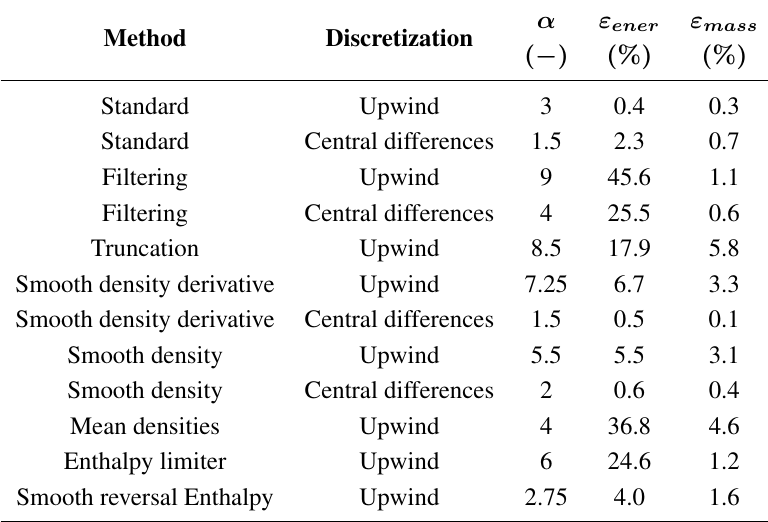
Table 4. Simulation results of the robustness test.